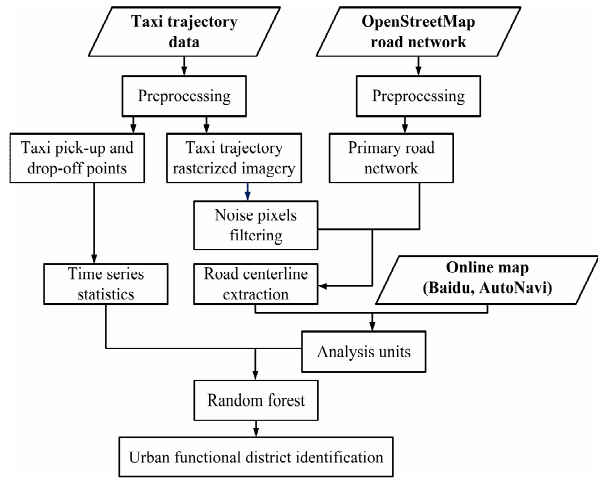
Figure 3. The workflow of the proposed